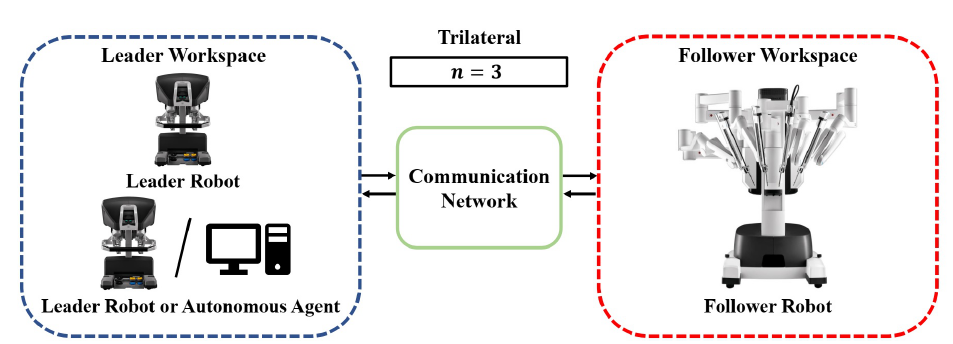
Figure 6. Trilateral topologies used in telerobotics, n is the number of network ports/terminals (Images ©2020 Intuitive Surgical,